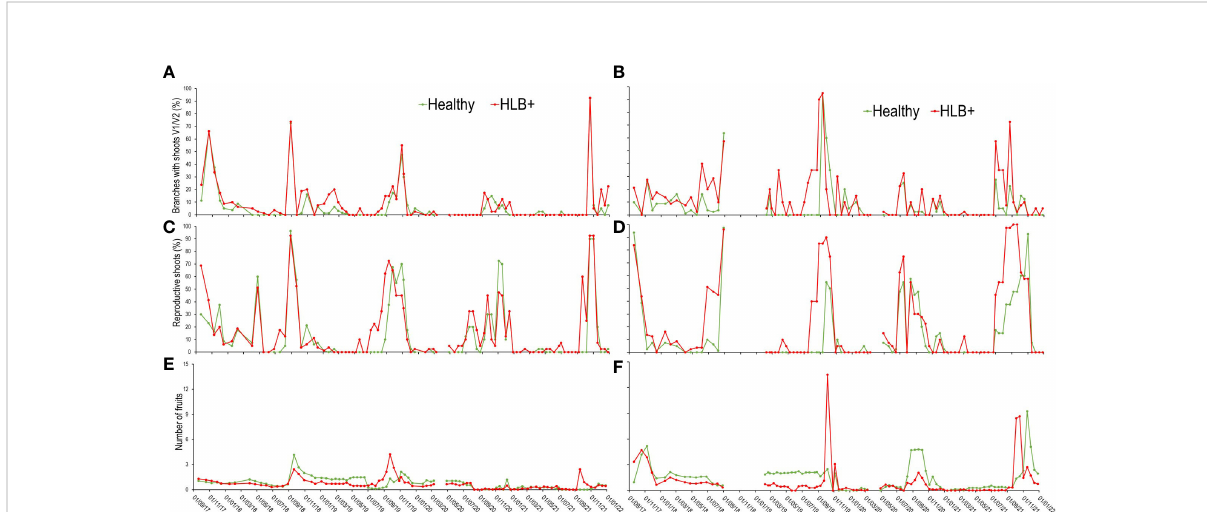
FIGURE 5 Patterns of the occupancy dynamics of new shoots in stages V1/V2 (A, B) , reproductive shoots (C, D) , and of the number of fruits (E, F) per tree. Each data point corresponds to the averages of 10 plants from the 1 st (19/1/2017) to the 23 rd (21/1/19) evaluation date, and of 5 plants from the 24 th (7/2/19) to the 97 th (27/12/19), in ‘ Femminello ’ lemon (A, C, E) and ‘ Valencia ’ sweet orange (B, D, F)